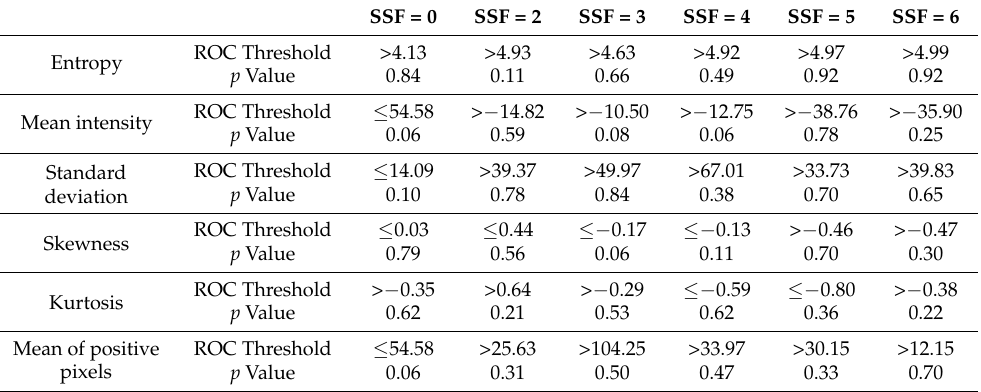
Table 5. ROC and Kaplan-Meier analysis for texture parameters after two treatment cycles at different scale values.